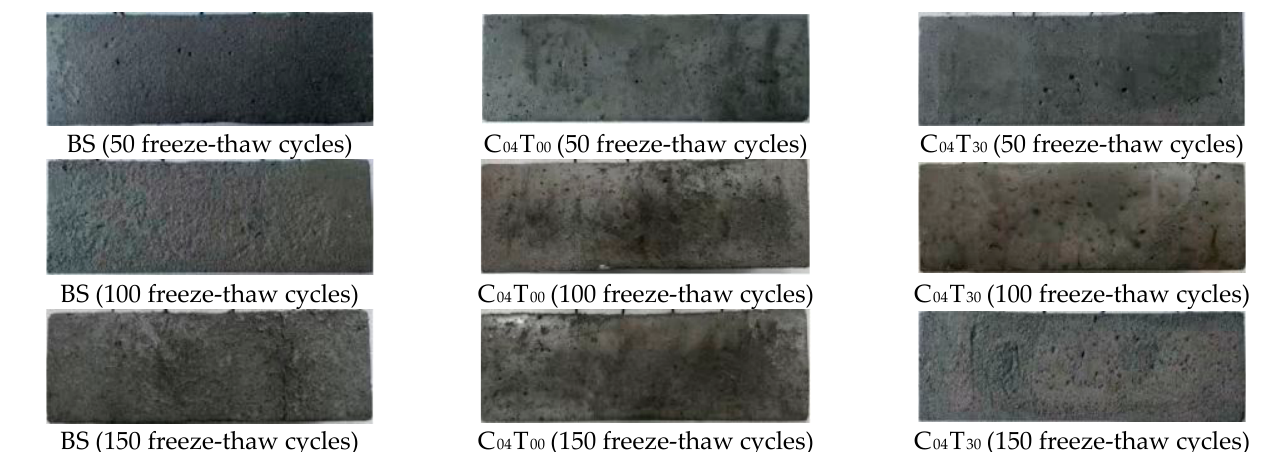
Figure 4. Apparent failure morphology of cement-based composites under freeze-thaw cycles.